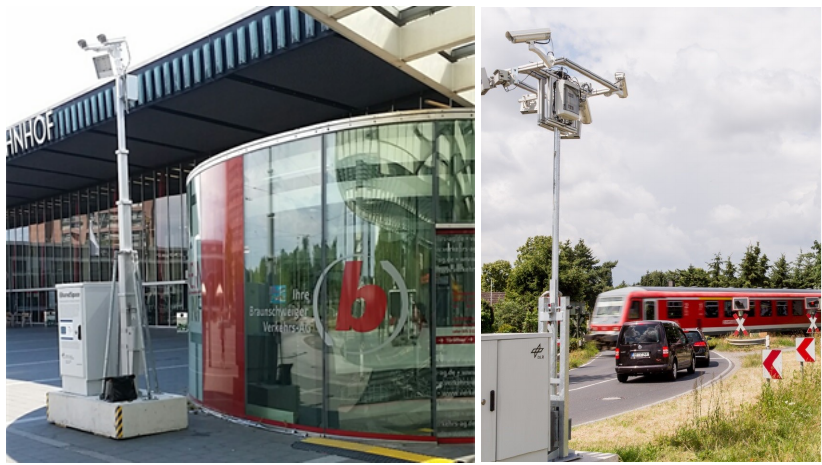
Figure 2: Mobile sensor poles at railway station and level crossing.